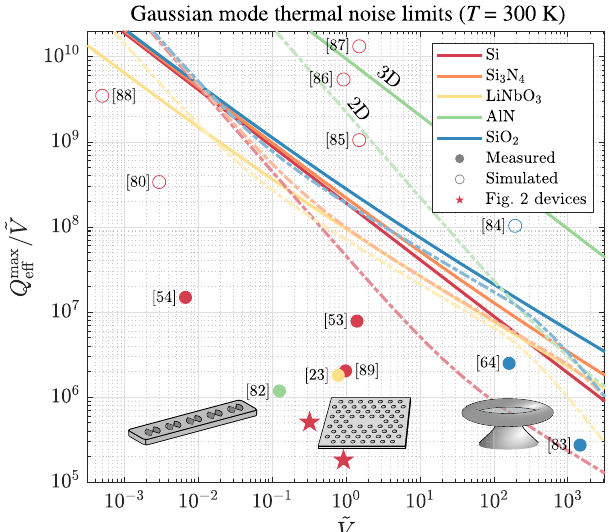
FIG. 4. Thermal-noise-limited room-temperature quality factor = ˜ V ) for the materials considered in to mode volume ratios ( Q max eff Appendix C assuming a Gaussian-shaped mode at λ 0 ¼ 1550 nm admitting thermal diffusion in two or three dimensions (dash- dotted and solid lines, respectively). These limits are compared our devices as well as other fabricated and proposed micro- cavities. Insets illustrate typical confinement geometries for the ˜ V range of listed (see Refs. [23,53,54,64,80,82 –